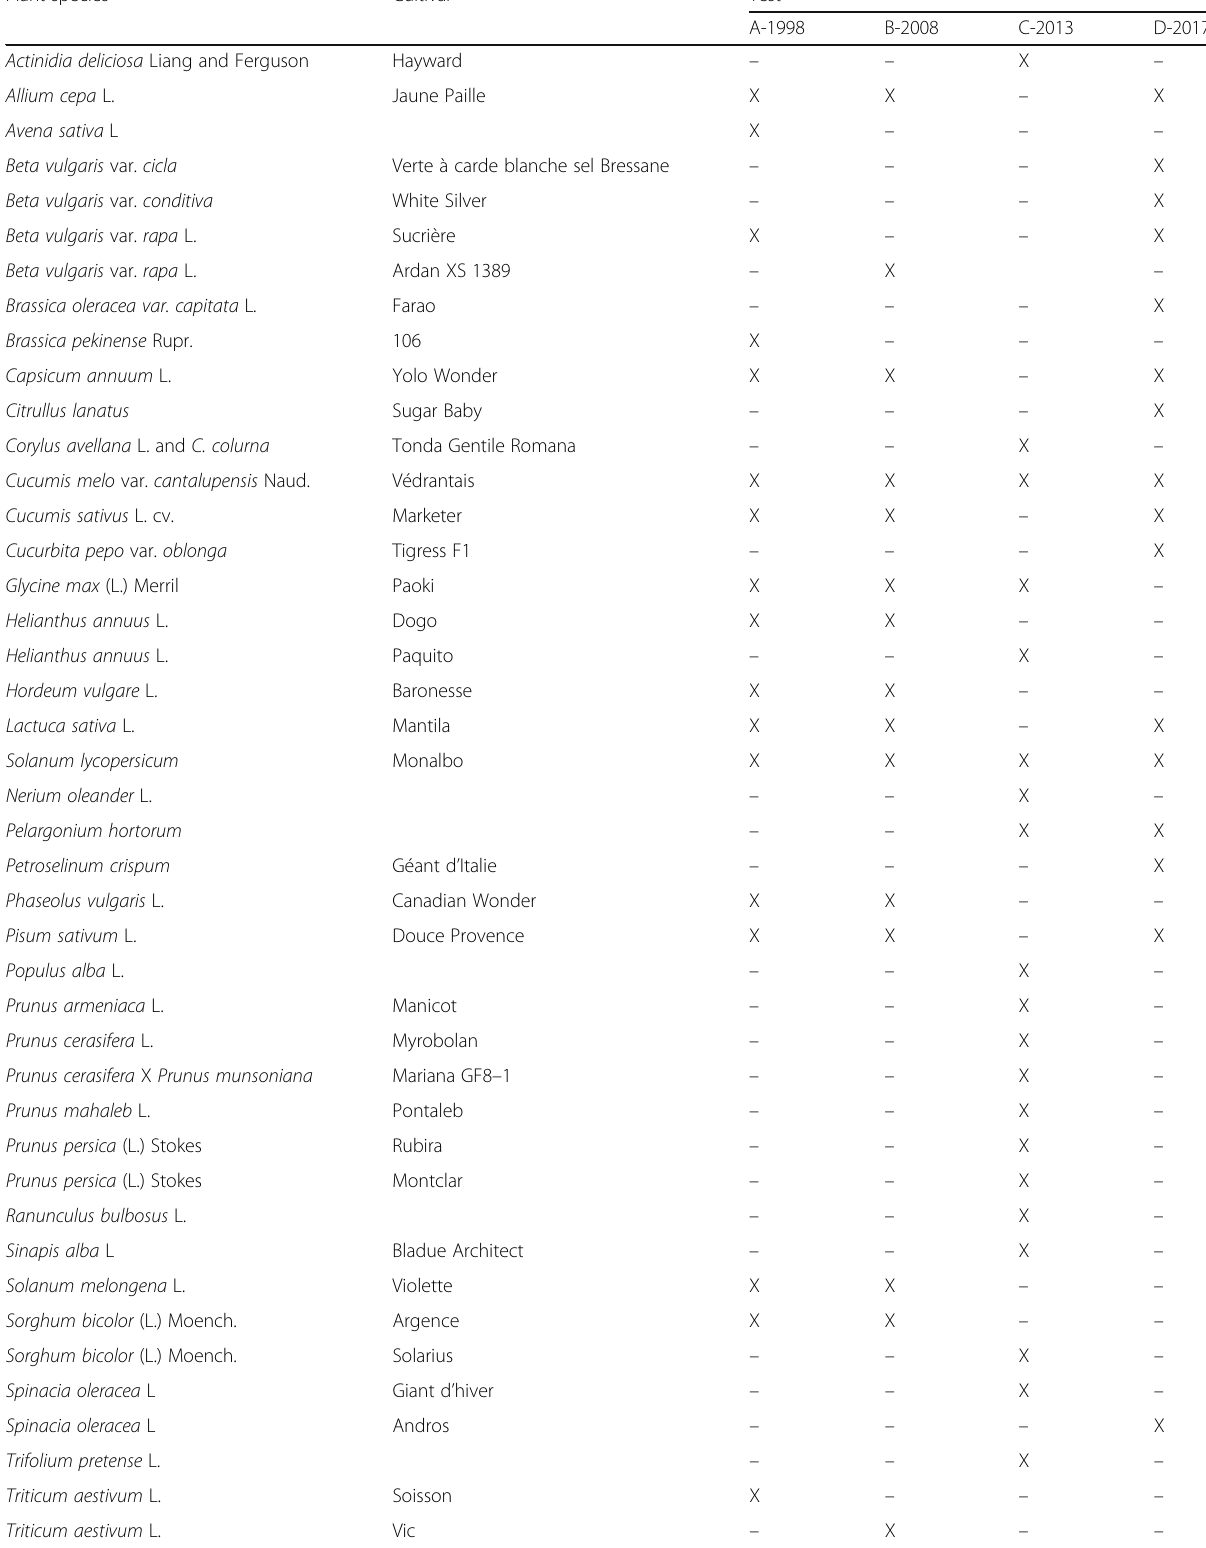
Table 5 Plant species and cultivars used in the four different tests of this study a Plant